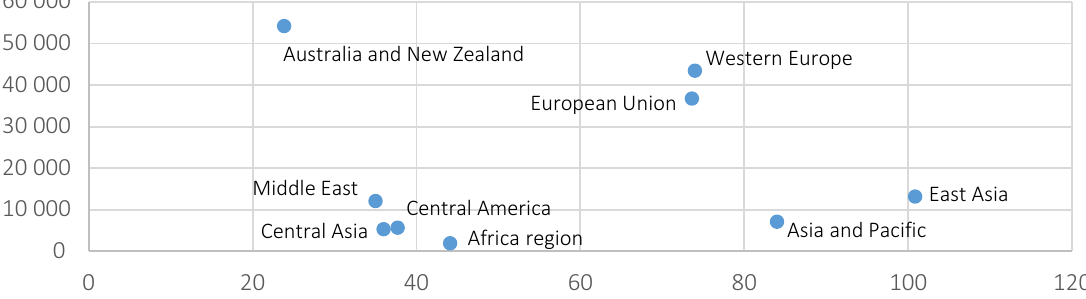
Figure 1. Average GDP per capita and average general goverment debt to GDP in